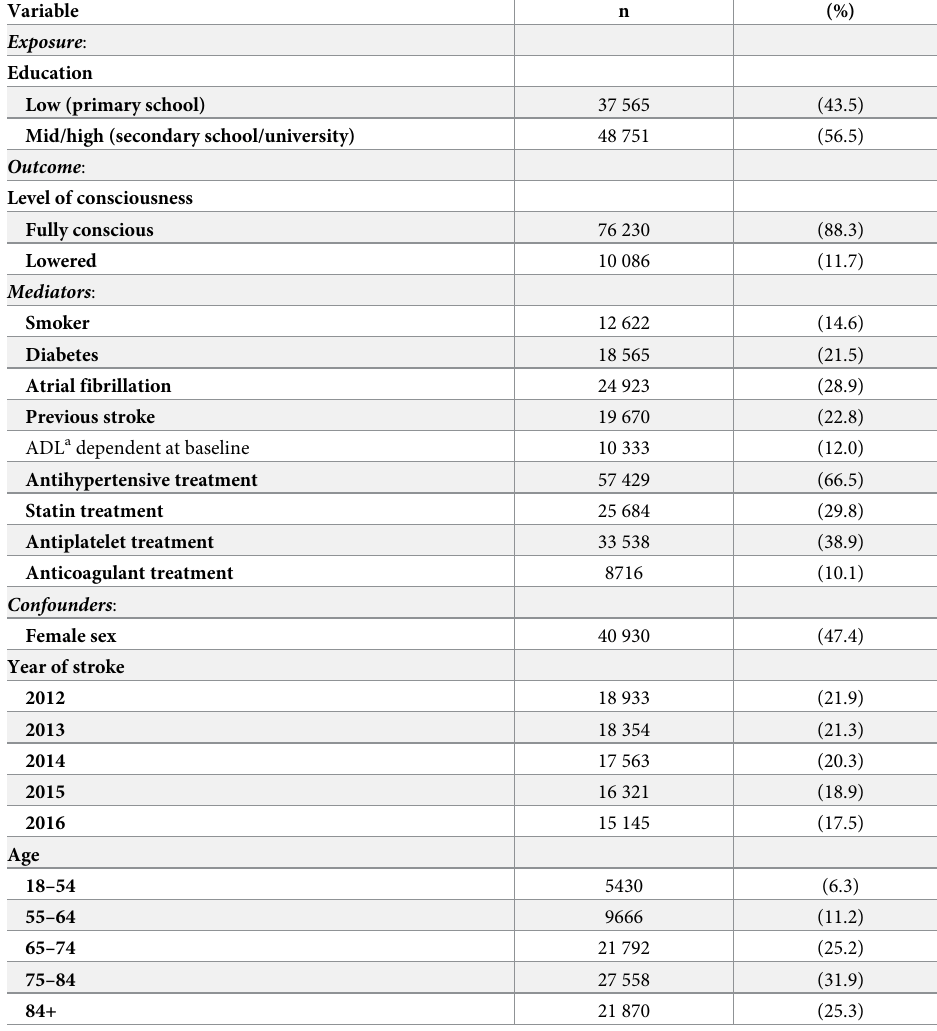
Table 1. Patient characteristics, complete records. Number